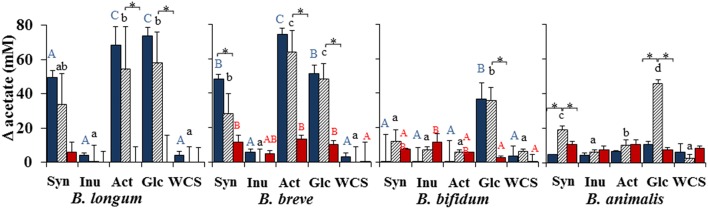
Increments, with respect to time zero, in the concentration of acetate on the bacterial cultures when grown in mono-culture (Bifidobacterium blue-bars and C. difficile red-bars) or in co-culture (stripped bars) in the prebiotics Synergy (Syn), Inulin (Inu), and Actilight (Act), in glucose (Glc) or without any carbon source added (WCS). Different letters above columns denote statistically significant differences (p < 0.05) among carbon sources in the corresponding bacterial cultures, either mono-cultures (capital letter; red color for bifidobacteria and blue color for C. difficile) or co-cultures (lowercase letters). *Indicates statistically significant differences (p < 0.05) for the corresponding bacterial strain between mono- and co-culture.